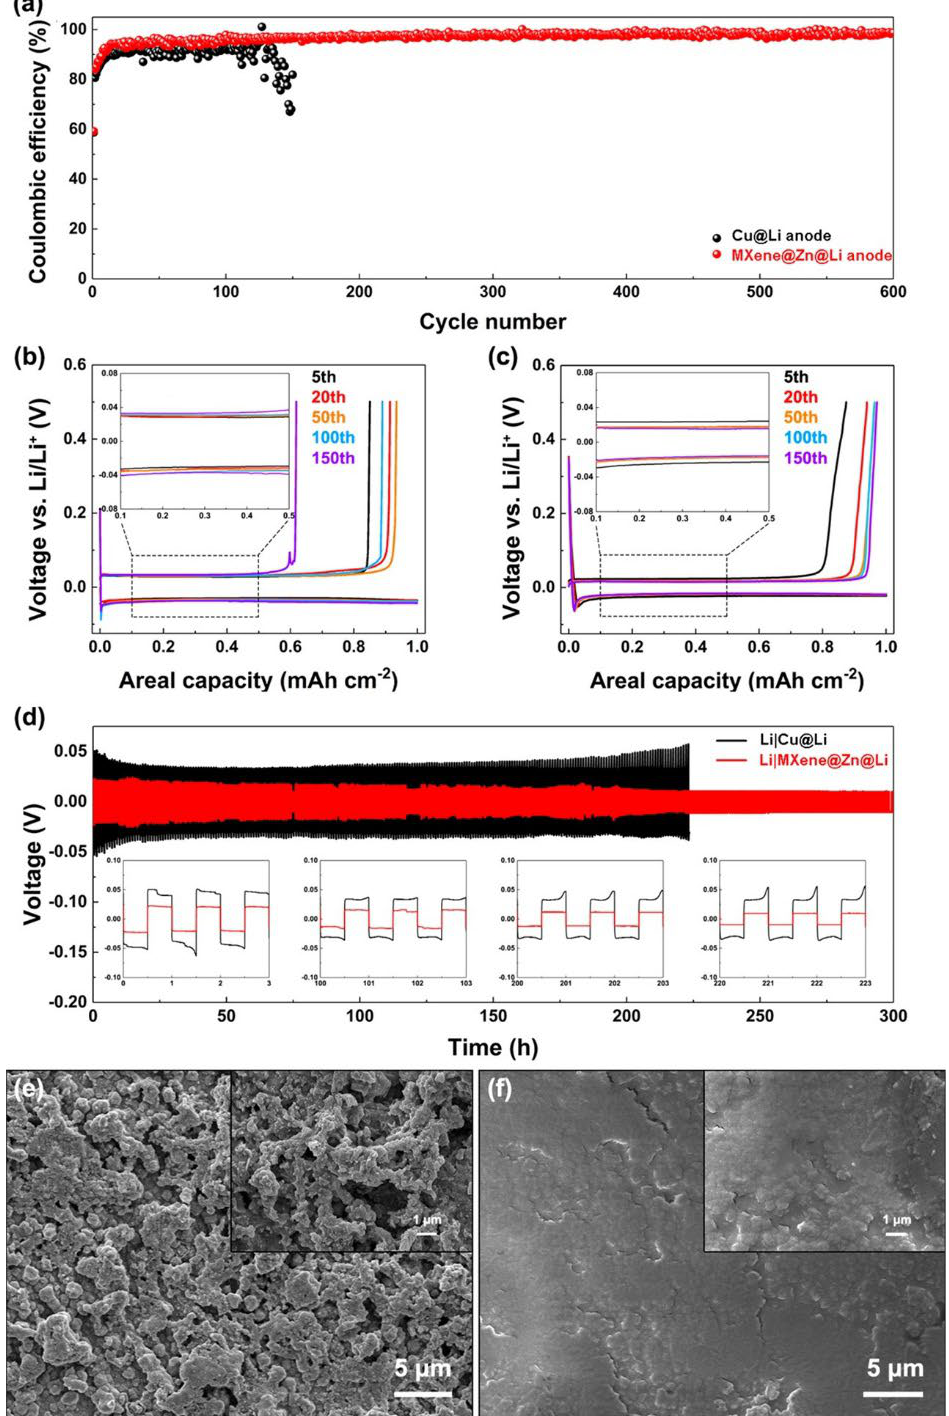
Figure 39. ( a ) The Coulombic efficiency of Li deposition on commercial Cu foil and Ti 3 C 2 T x MXene@Zn electrodes at a current density of 1 mA cm −2 with a fixed areal capacity of 1 mAh cm −2 . The corresponding Li stripping/plating profiles for ( b ) planar Cu and ( c ) Ti 3 C 2 T x MXene @Zn electrodes at different cycles. ( d ) Voltage profiles of Li plating/stripping at a current density of 1 mA cm −2 with an areal capacity of 1 mAh cm −2 in symmetric Li|Li-Cu cells and Li|Li-MXene@Zn cells, respectively. Top view of SEM images of ( e ) Cu and ( f ) Ti 3 C 2 T x MXene@Zn electrodes after cycling. Reprinted with permission from [72]. Copyright 2019 American Chemical Society.